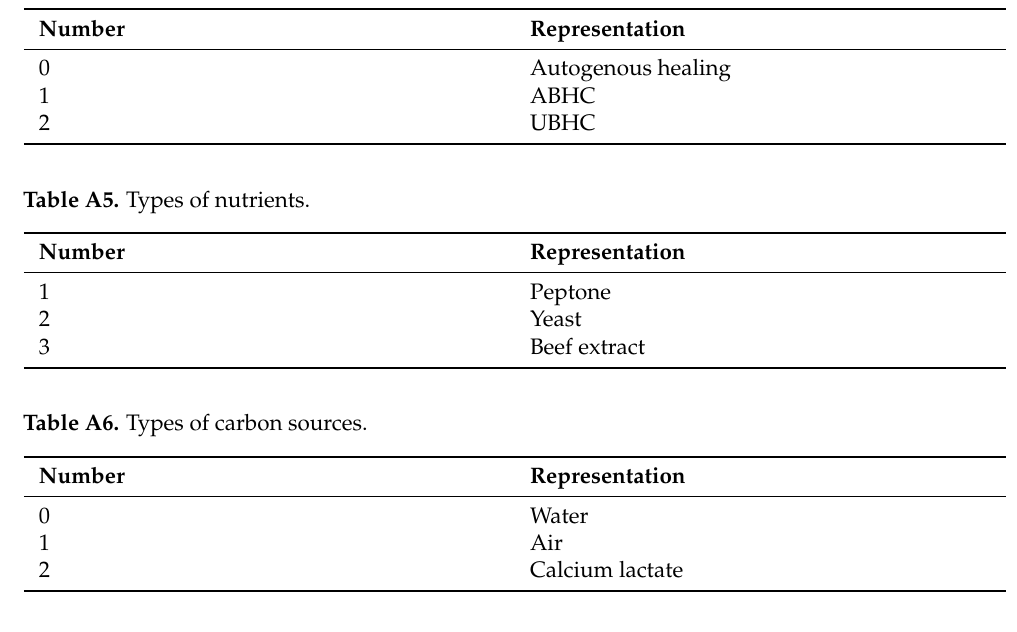
Table A7. Types of cement.